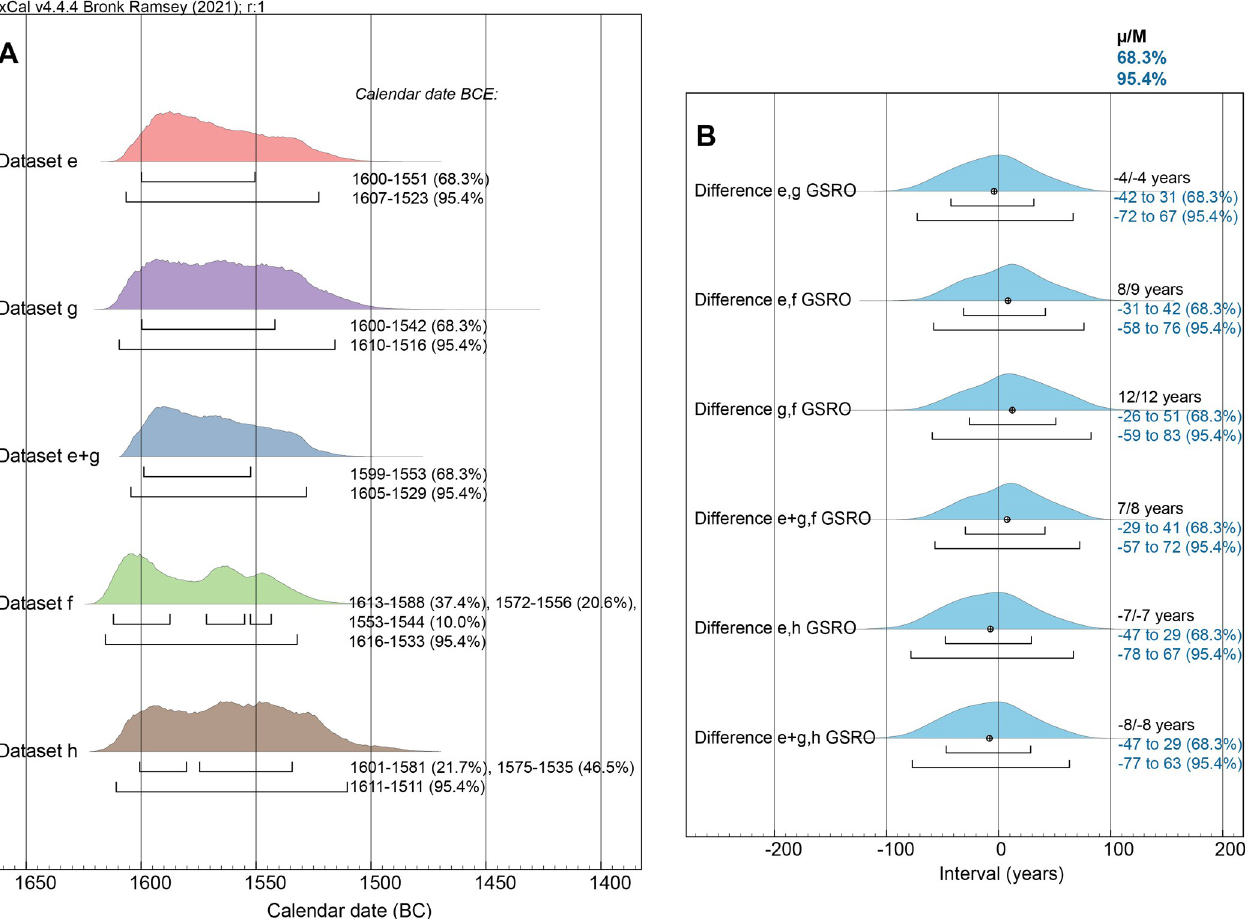
Fig 8. A re-run of the Fig 7 data and models, as datasets (e) to (h), but allowing in each case for the southern Aegean likely worst-case GSRO factor.